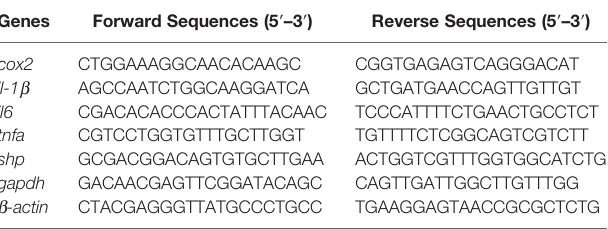
TABLE 1 | Primers used for qPCR analysis.